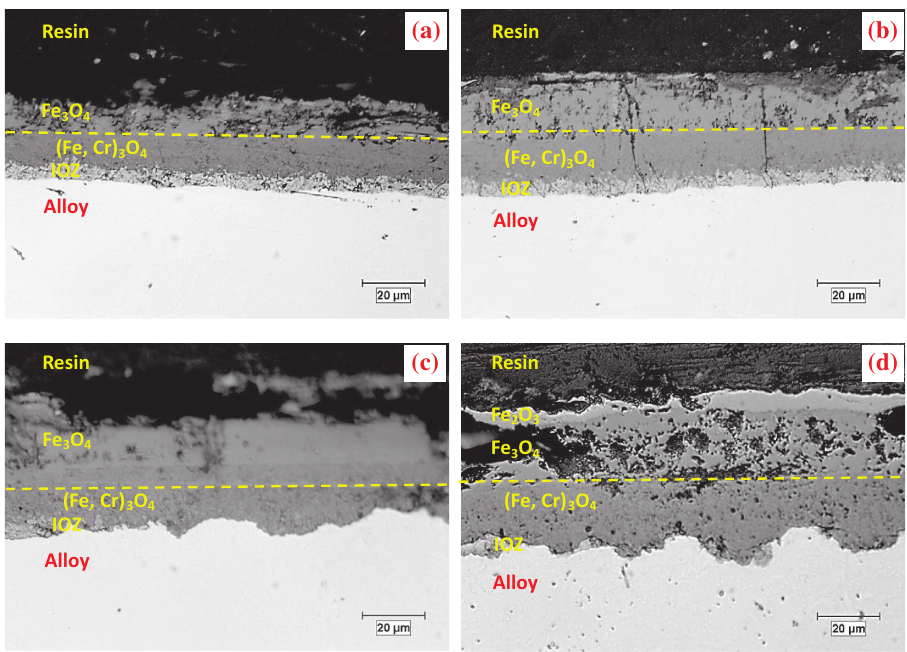
Figure 5: Cross-section morphologies of T92 steel with #1000 grit finish after different times (a) 12.5h, (b) 25h, (c) 50h, and (d)